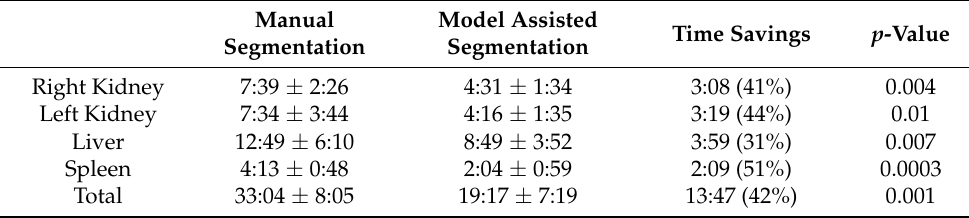
Table 4. Mean time (minutes) for manual organ segmentation and model assisted segmentations for the first 10 prospective cases averaged over four trained